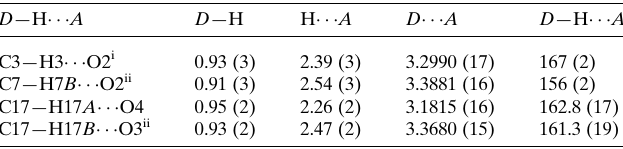
Table 2 Hydrogen-bond geometry (A˚ , (cid:4) ).